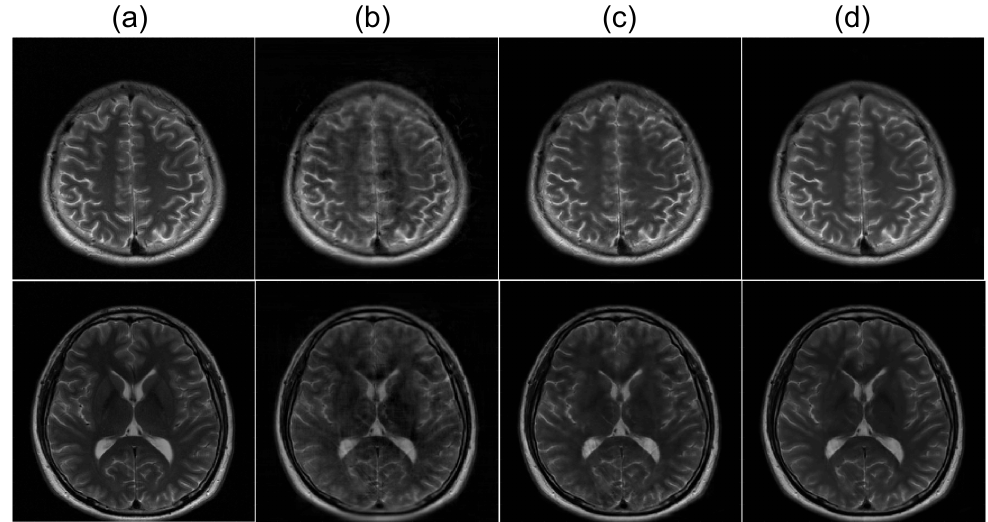
Figure 4. Comparison of three different refinement networks (Section 4.1). Two example slices of experiment results are shown. ( a ): Ground truth magnitude images (label images). ( b – d ): Recon- structed images using ( b ) single convolutional layer, ( c ) WTA, and ( d )